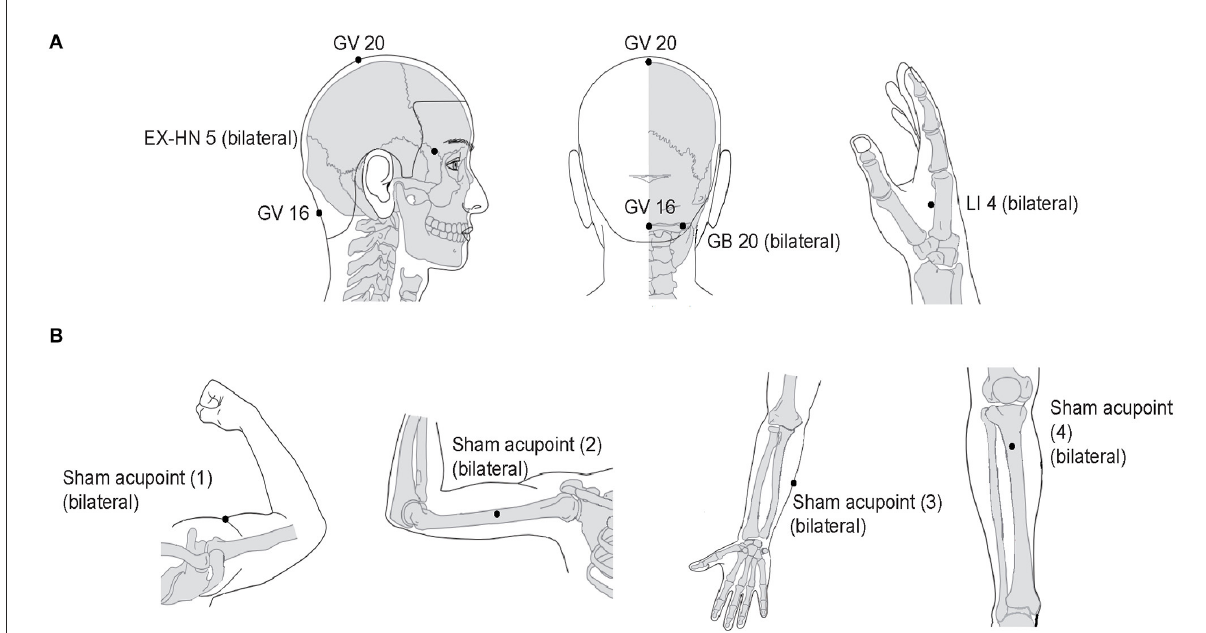
FIGURE2 Location of real acupoints and sham acupoints. (A) Real acupoints. (B) Sham acupoints. EX-HN, Extrachannel points; GB, Gallbladder Meridian; GV, Governor Vessel; LI, Large Intestine Meridian.